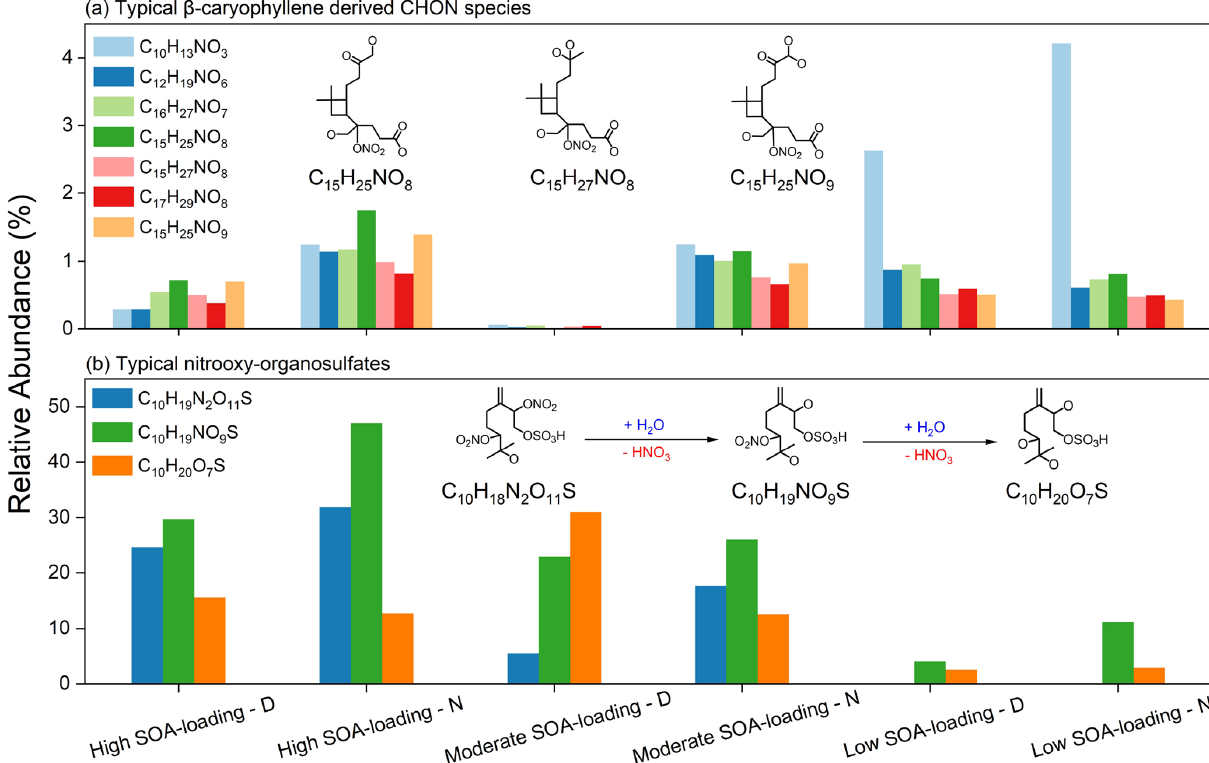
Figure 7. (a) Relative abundance distributions of typical CHON compounds derived from β -caryophyllene. Some of the proposed chemical structures have been reported in a previous study (Chan et al., 2010). (b) Relative abundance distributions of typical nitrooxy–organosulfates. The hydrolysis reactions and the proposed chemical structures have been reported in a previous study (Lin et al., 2012).